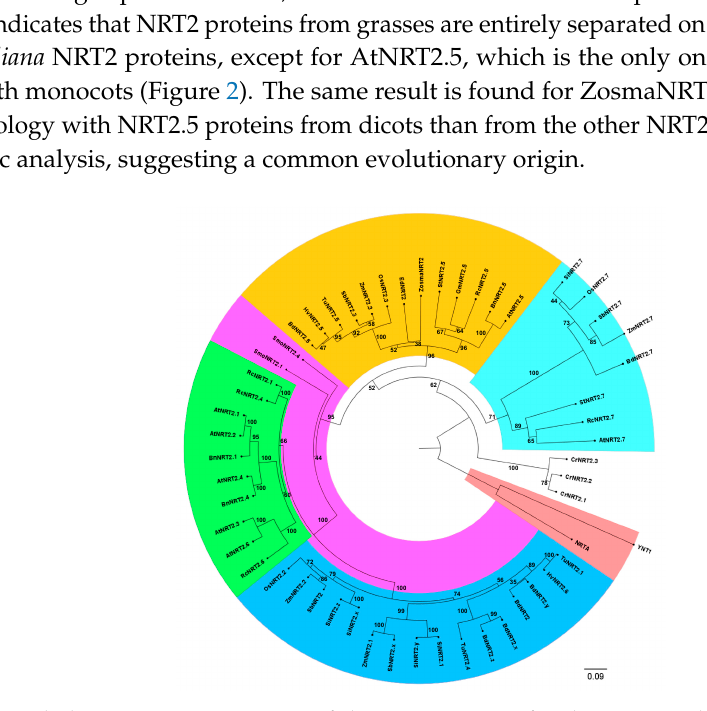
and visualized by the FigTree v1.4.4 software. Different colors are used for each clade. The scale bar represents a 0.09 estimated amino acid substitution per